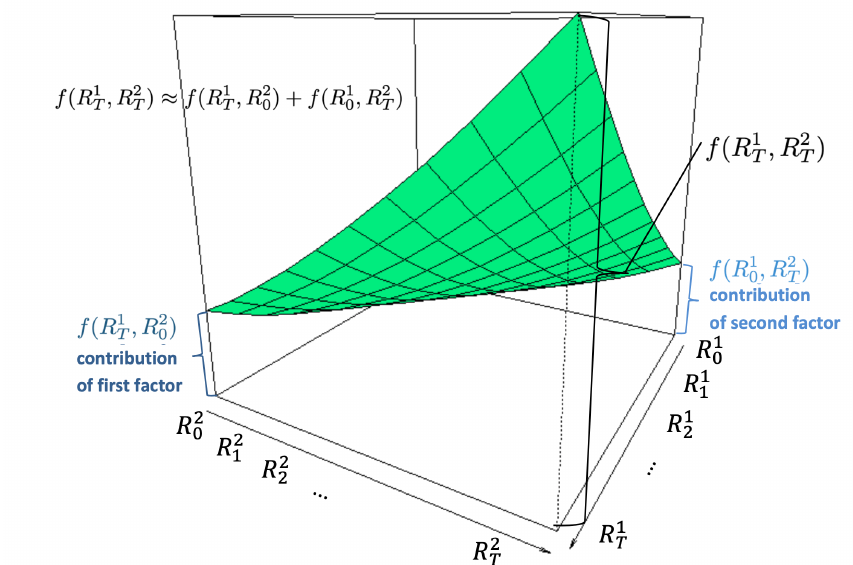
) and f ( R 1 ) from the initial time to time T , R 2 , R 2 T T 0 0